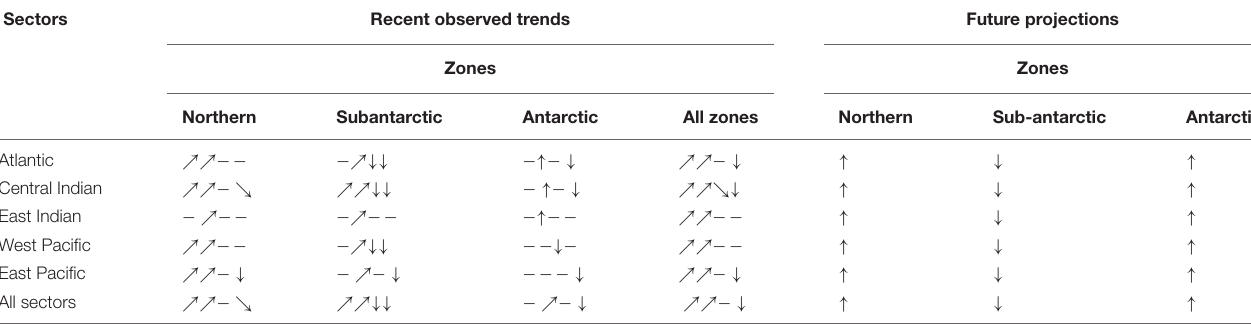
TABLE 4 | Summary of recent observed changes (satellite data) and future projections by MEASO areas of the Southern Ocean. Sectors